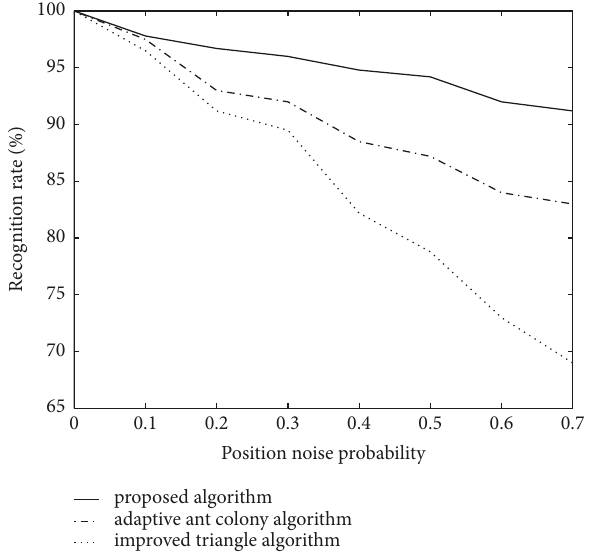
Figure 5: Recognition results under position and magnitude noise.